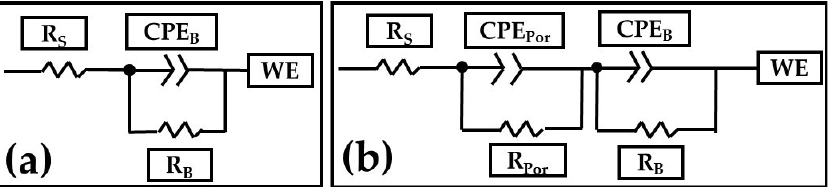
Figure 11. Electrical equivalent circuits from different samples. ( a ) un-anodized AA2024 and ( b ) citric–sulfuric acid-anodized samples with i = 3 and 4.5 A/dm 2 immersed in 3.5 NaCl solution.